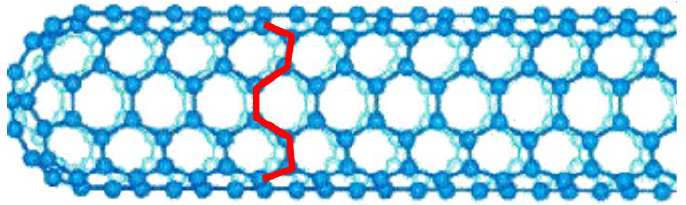
Figure 10. n = m (chiral angle = 30 ◦ tubes are called “armchair”). Adapted from Weisman, 2004, p. 24.